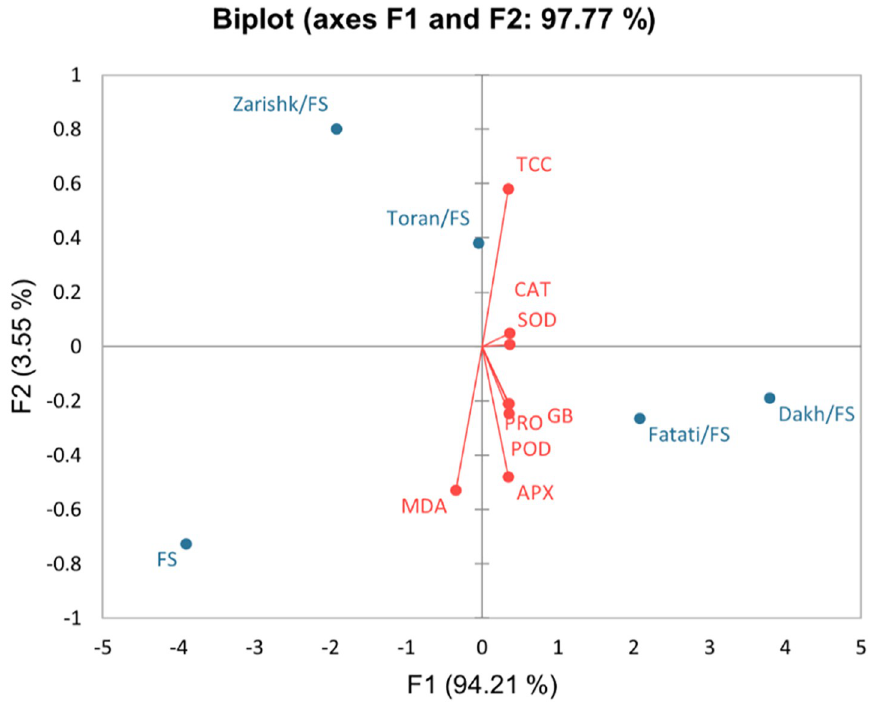
Fig 17. Bi-plot graph of the first (PC1) and second (PC2) principal components of enzymatic and non-enzymatic biochemical traits in un-grafted and grafted Flame Seedless scion variety on different wild grapevines under -8 bars of drought